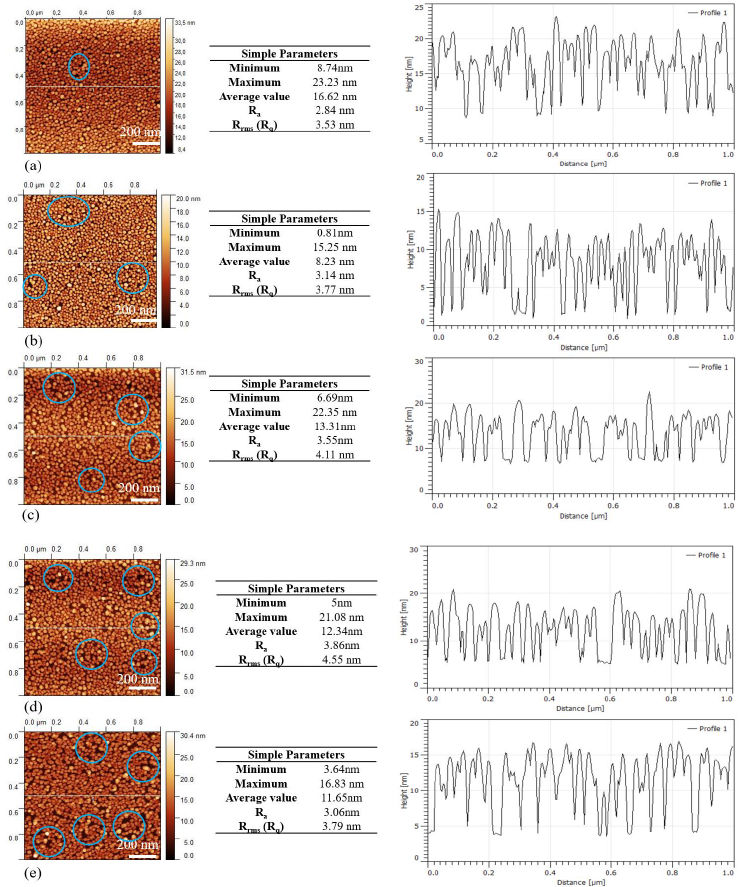
Figure 7. AFM images of annealed AuNPs modified by different concentrations of BPE model molecules, cross-section analysis was based on the profile line analysis. ( a ) 10 − 3 M BPE; ( b ) 10 − 5 M BPE; ( c ) 10 − 7 M BPE; ( d ) 10 − 9 M BPE; ( e ) 10 − 11 M BPE. The AFM measurements were performed under cleanroom conditions at 21 ◦